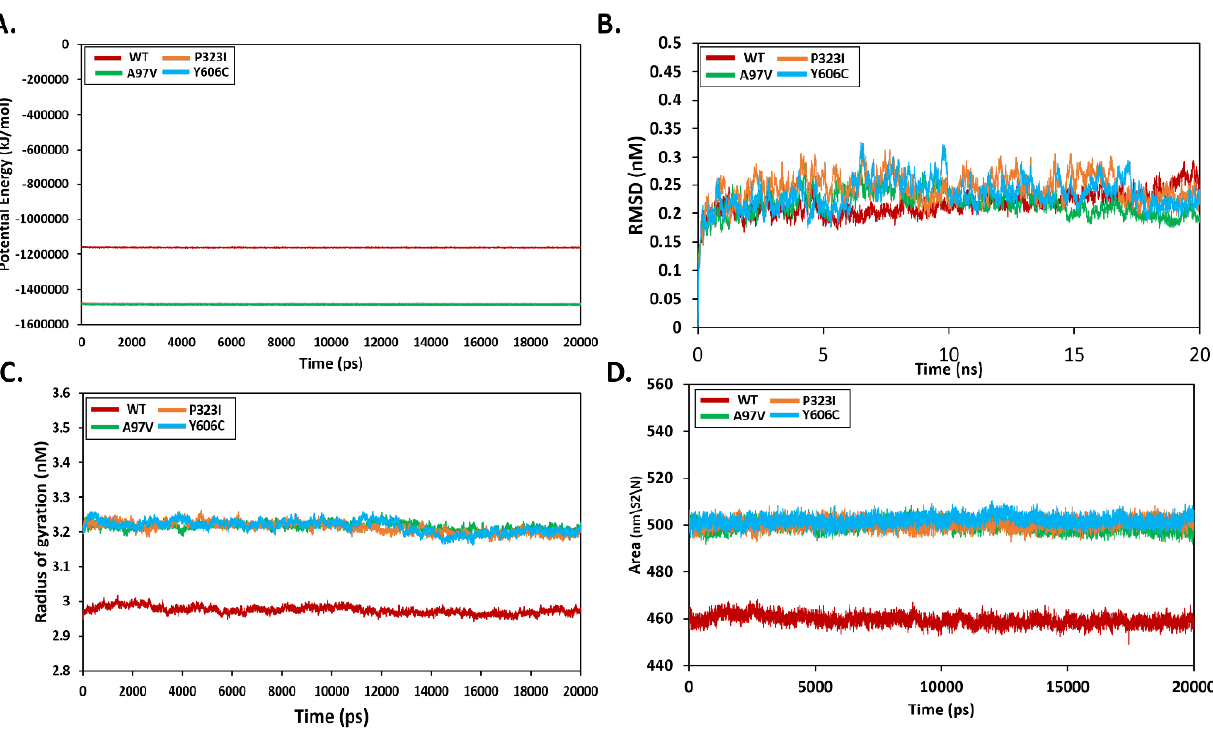
Figure 4. Molecular dynamics simulation analysis of wild-type and mutant RdRp enzymes. ( A ) — potential energy, ( B ) — RMSD, ( C ) — gyration, ( D ) — SASA.